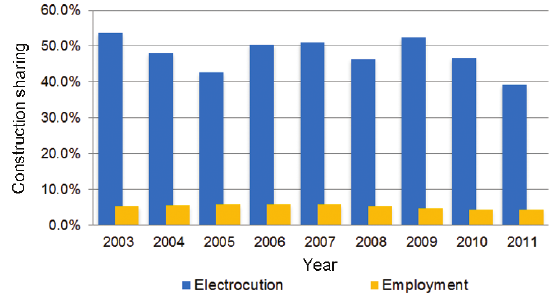
Fig. 1. US Construction’s shares in Electrocution and Employment, 2003–2011 Note : data source is U.S. Bureau of Labor